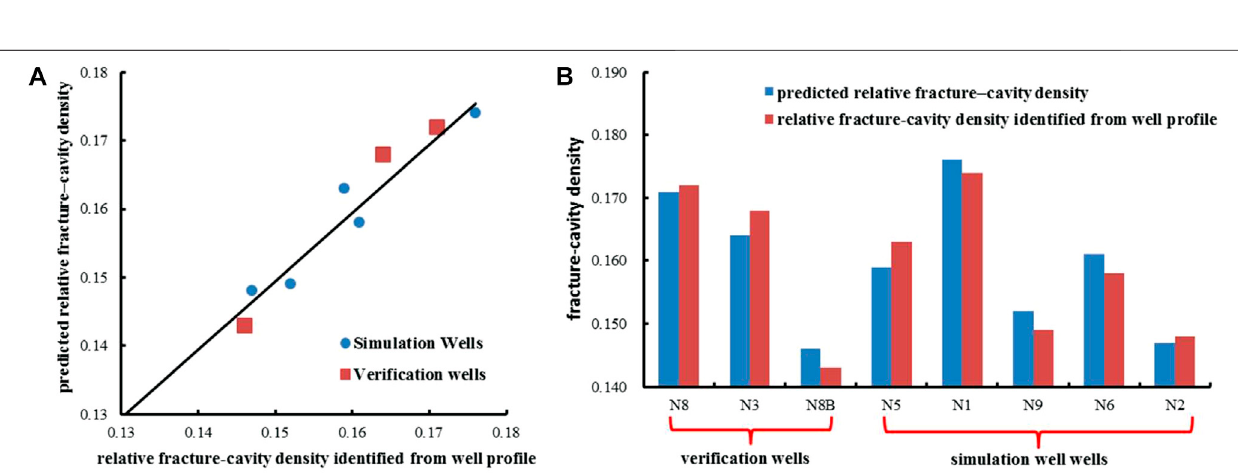
Frontiers in Earth Science |